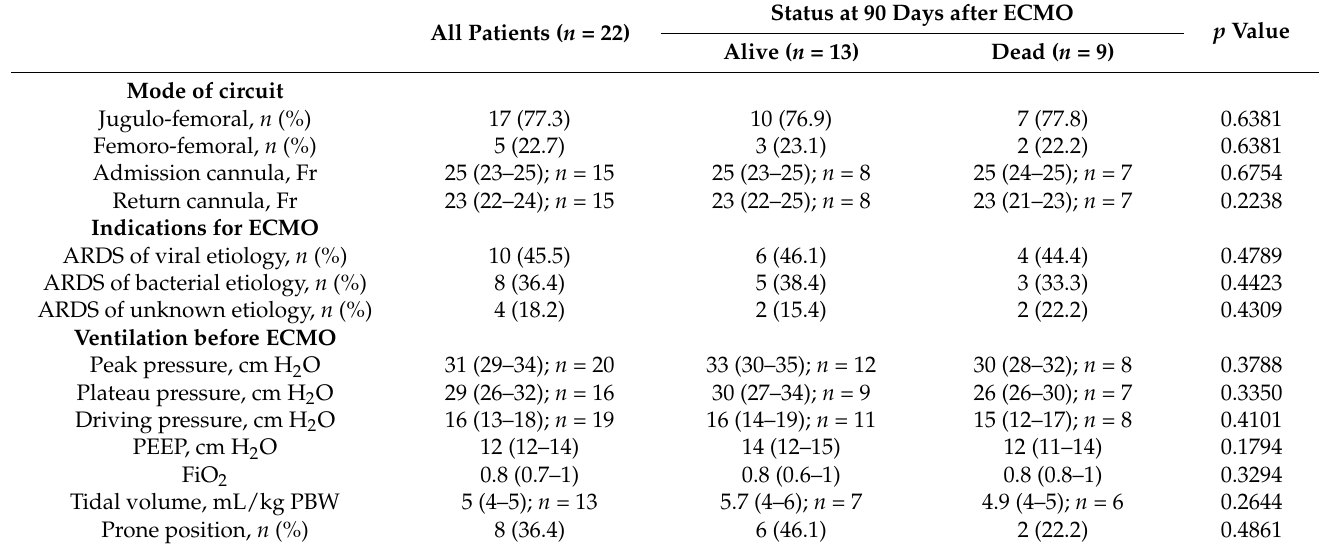
Table 2. Characteristics of patients on